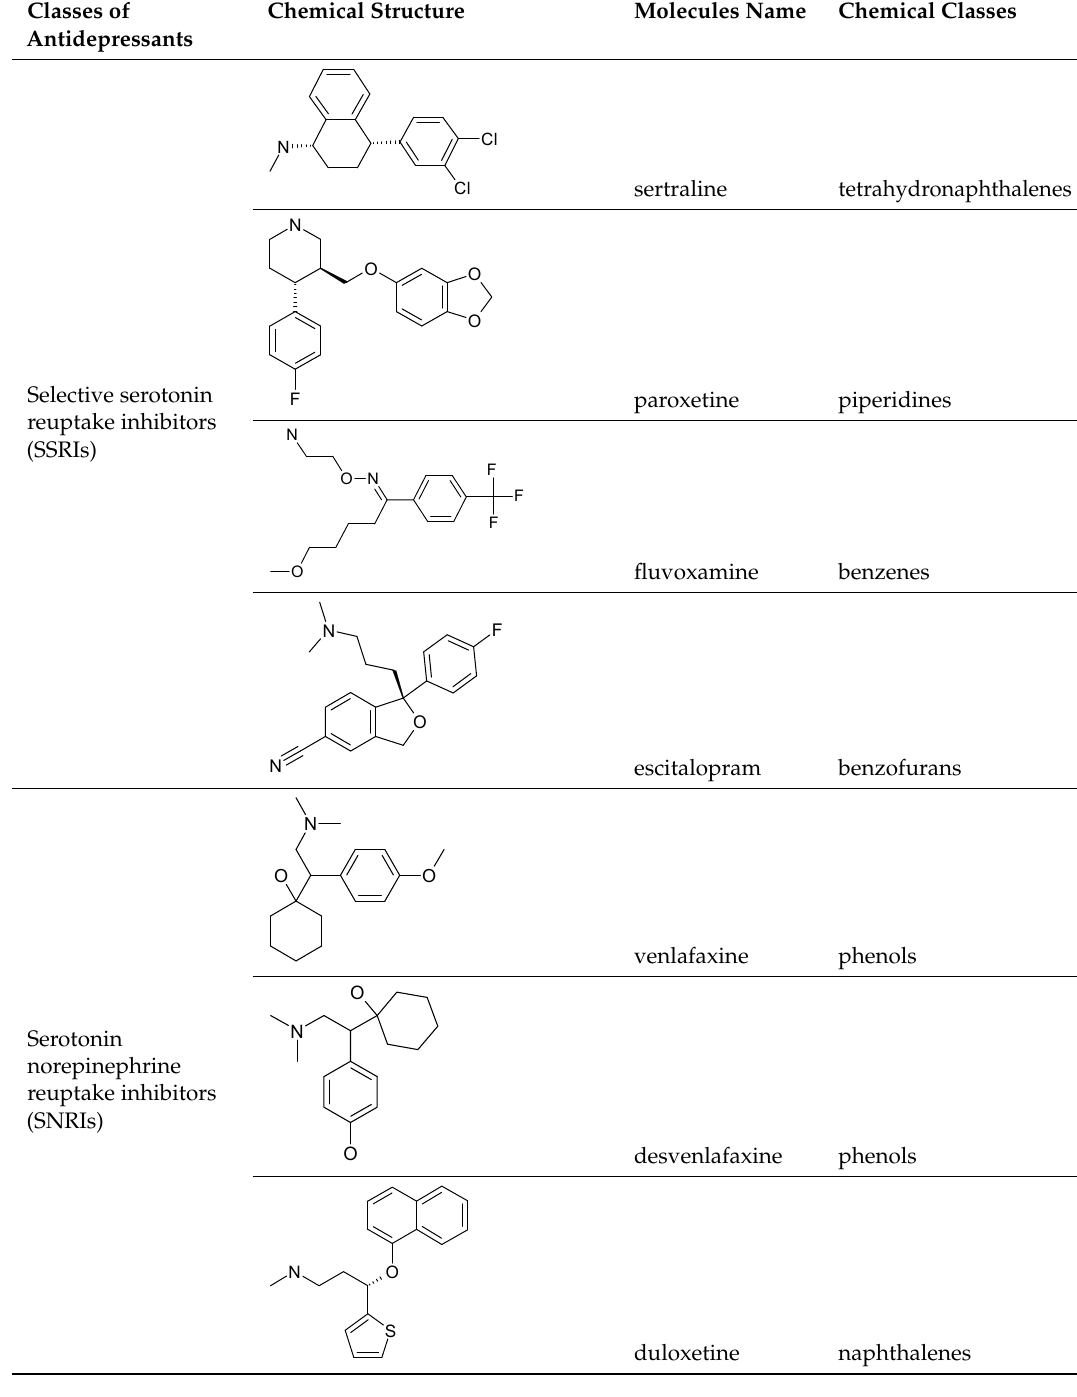
Table 3. Antidepressants and antipsychotics classifications.